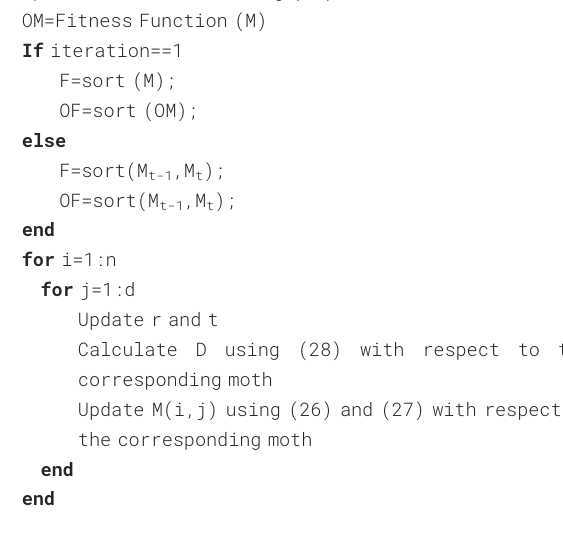
Algorithm 3: Overall stages of function P (Mirjalili, 2015).